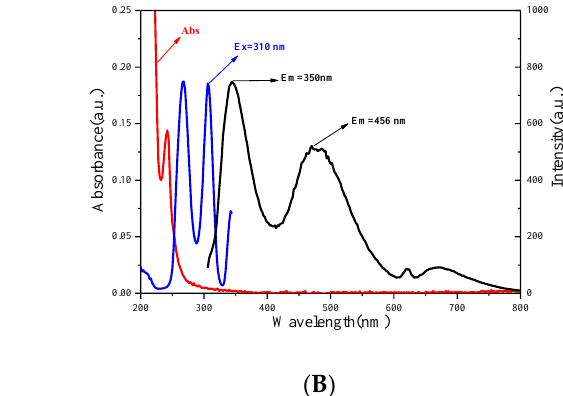
( B ) Figure 5. Effect of ( A ) pH under the same conditions (system temperature: 44 °C; N-CDs: 100 µL; MOR concentration: 10 μg/mL; Ex: 310 nm; Em: 350 nm and 456 nm) and ( B ) system temperature under the same conditions (pH: 8.0; N-CDs: 100 μL; MOR concentration: 10 μg/mL; Ex: 310 nm; Em: 350 nm and 456 nm). 3.4. System Temperature Temperature has an effect on the return of excited electrons to the ground state to produce changes in fluorescence intensity. Thus, the effects of system temperatures of 14, 24, 34, 44, 54, 64, and 74 °C on the fluorescence intensity were explored (Figure 5B). The results show that the fluorescence ratio of I 350 /I 456 decreased from 14 °C to 44 °C and then increased when the temperature increased from 44 °C to 74 °C. Considering this com- prehensively, the temperature of the system was chosen at room 44 °C. The temperature change feature could be attributed to the temperature-enhanced population of non-radiative channels of surface (trap/defect) states. More non-radiative channels would be activated at a higher temperature, and more excited electrons returned to the